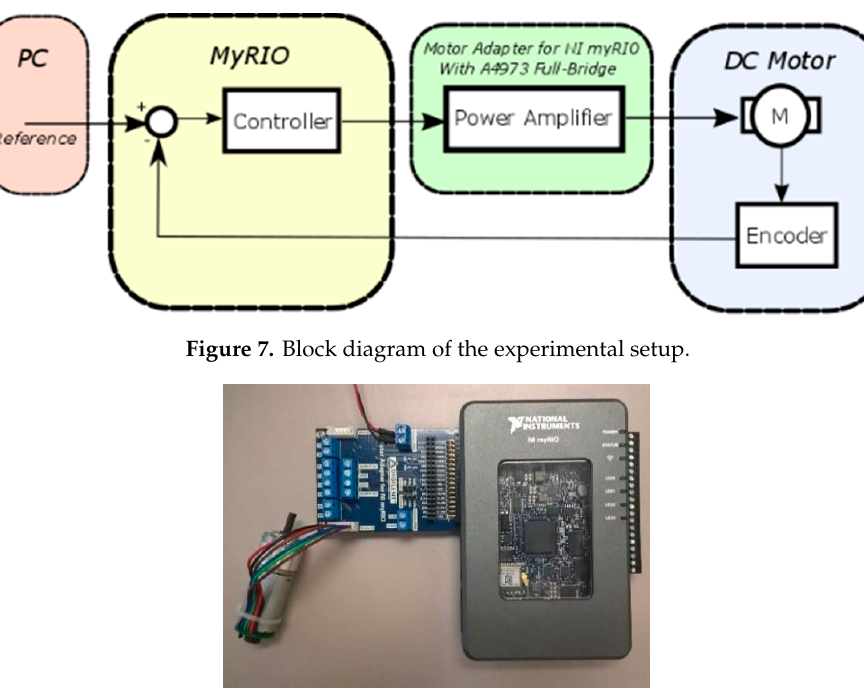
Figure 8. MyRIO system with a motor adapter and a DC motor used in undergraduate engineering control systems classes. control systems classes.